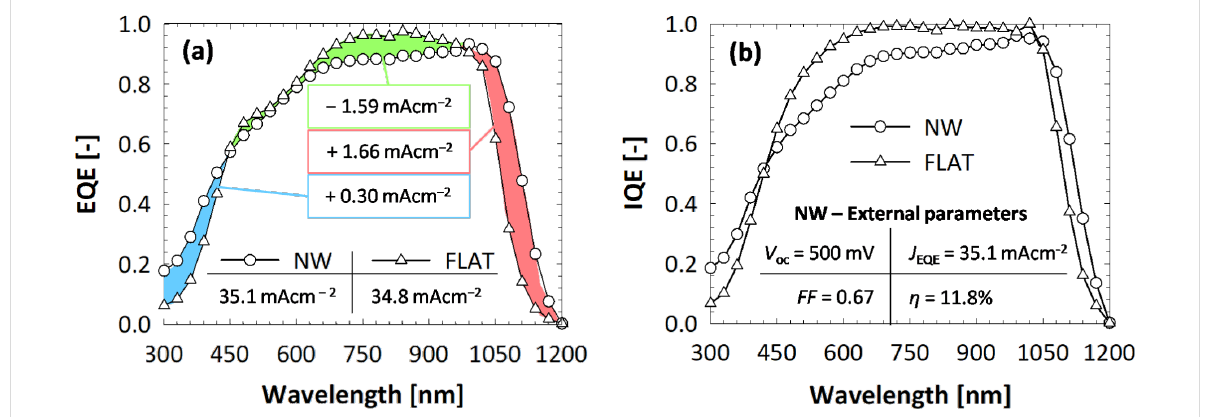
Figure 2: Measured (a) EQE and (b) IQE of the best nanowire heterojunction solar cell (NW) and of the flat heterojunction reference (FLAT). The blue and red areas in (a) indicate the net current gain of the NW structure with respect to the FLAT counterpart at short and long wavelengths, respective- ly, while the green area indicates the net current loss in the central region of the spectrum of the NW device with respect to FLAT device. The table in (b) reports the external parameters of the best NW